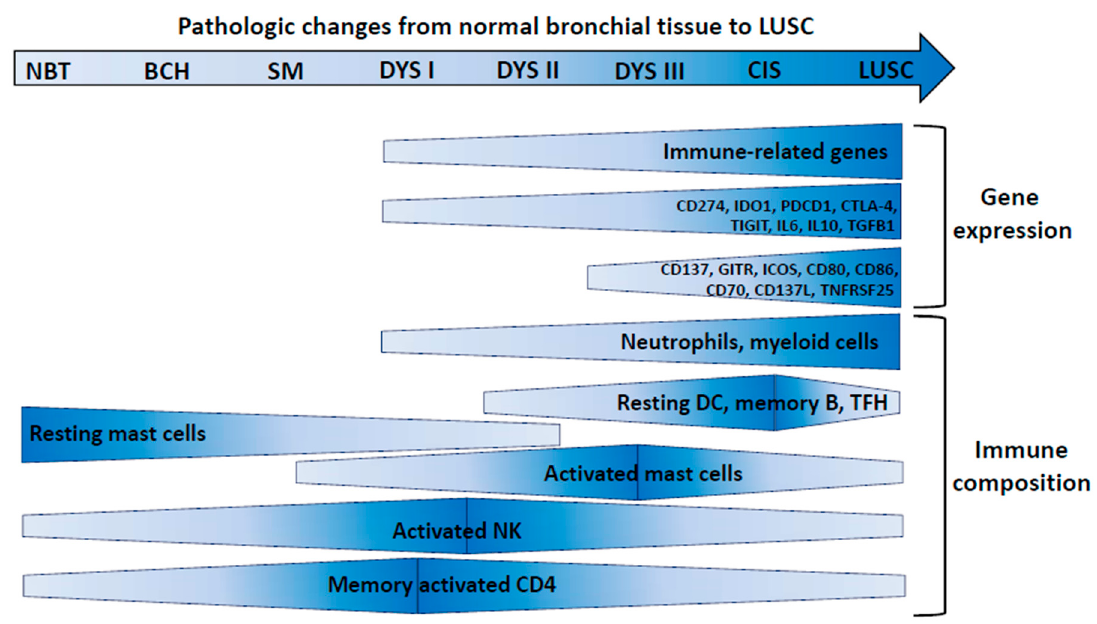
Figure 2. Immune evolution in LUSC pre-invasive lesions. Changes in the indicated parameters along with progression of pre-invasive lesions to LUAD are shown by size and color of the shapes (larger vertical size and darker color: increase). NBT: normal bronchial tissue; BCH: basal cell hyperplasia; SM: squamous metaplasia; DYS I–III: grade I–III dysplasia; CIS: carcinoma in situ; LUSC: lung squamous cell carcinoma. DCs: dendritic cells; TFH: T follicular helper cells; NK: natural killer cells.